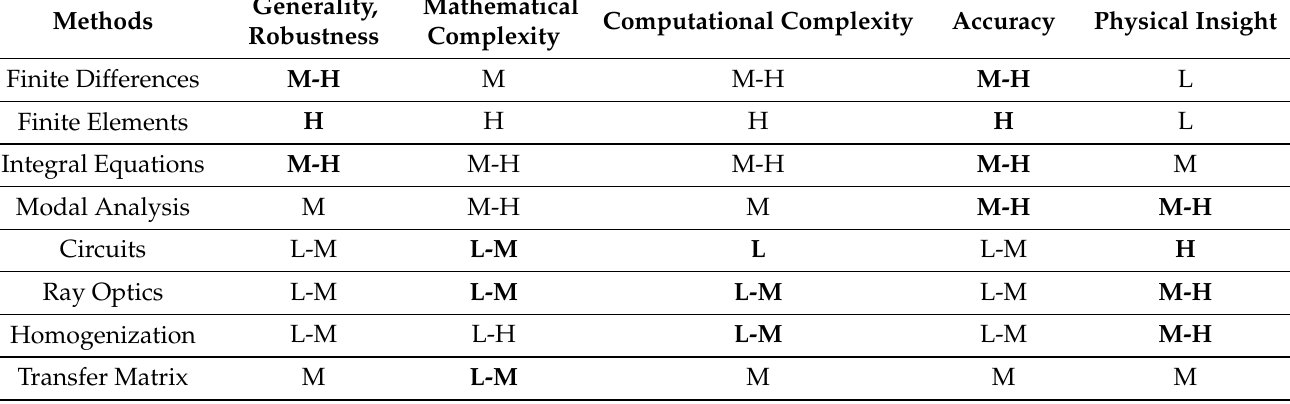
Table 1. Strengths and weaknesses of the discussed computational techniques applied to 3-D